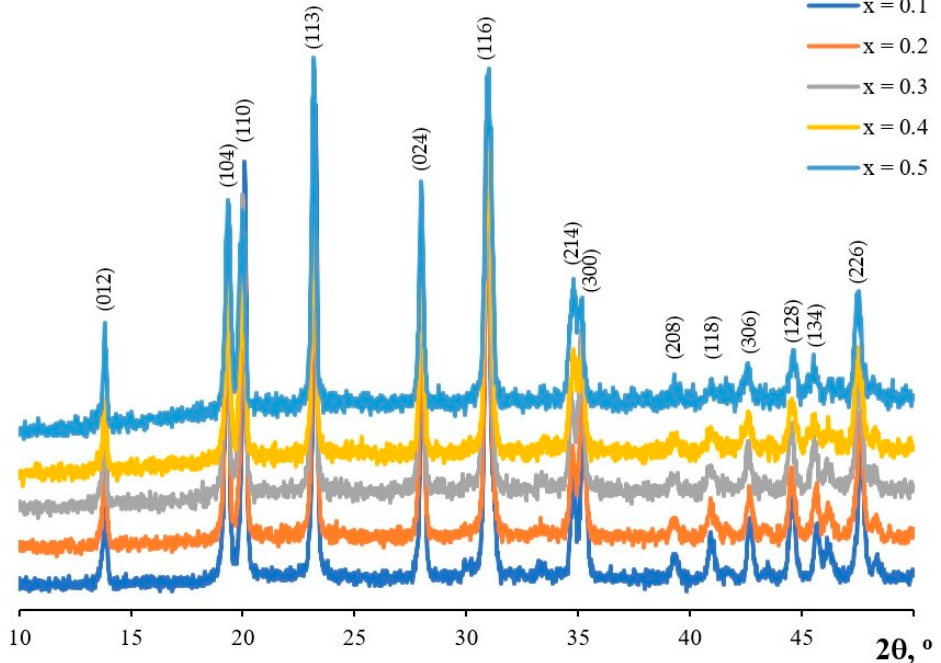
Figure 3. XRD data for powders Na 1+2x Zr 2-x Co x (PO 4 ) 3 . Diffraction angle indices are provided in ac- cordance with the data for the NaZr 2 (PO 4 ) 3 compound (PDF #00-033-1321). The graphs of the dependence of unit cell parameters of Na 1+2x Zr 2-x Co x (PO 4 ) 3 com- pounds on the composition are shown in Figure 4. It was found that with an increase in the cobalt content, there is a tendency towards an increase in the a parameter and a de- crease in the c parameter. Lattice parameter values are provided in Table 1. The behavior of solid solution Na 1+2x Zr 2-x Co x (PO 4 ) 3 specimens after heating at temperatures ranging from 25 to 700 °C was anticipated and typical of NZP compounds: a unit cell expands along the c axis and contracts along the a and b axes. This data is based on the results of high-temperature radiography (Figure 5).